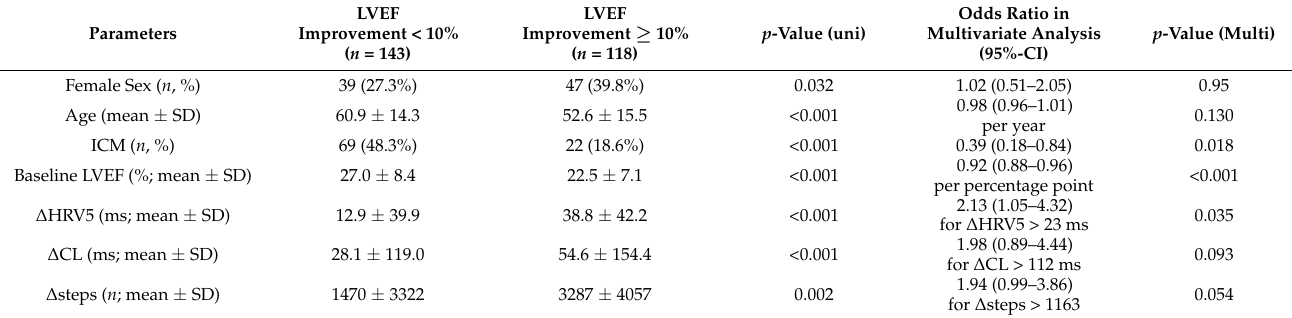
Table 5. Univariate and multivariate logistic regression for an LVEF improvement of at least 10% between prescrip- tion and three-month follow-up with the delta of HRV5 and CL measured within the first 45 days of WCD wear time; WCD = wearable cardioverter–defibrillator; LVEF = left ventricular ejection fraction; SD = standard deviation; CL = cycle length; ICM = ischemic cardiomyopathy; HRV5 = heart rate variability approximate. In 10 patients no exact LVEF at three months was available and thus no response could be classified. p -values given are for logistic regression models, see text. LVEF Parameters Improvement < 10% ( n =